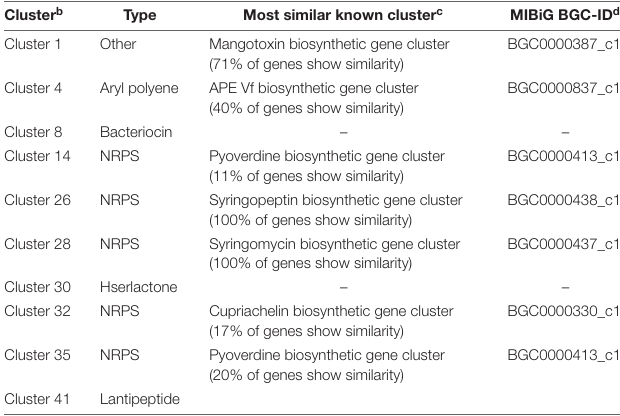
TABLE 2 | Secondary metabolite and antibiotic gene clusters in Pseudomonas sp. 11K1 predicted by antiSMASH 4.0 a